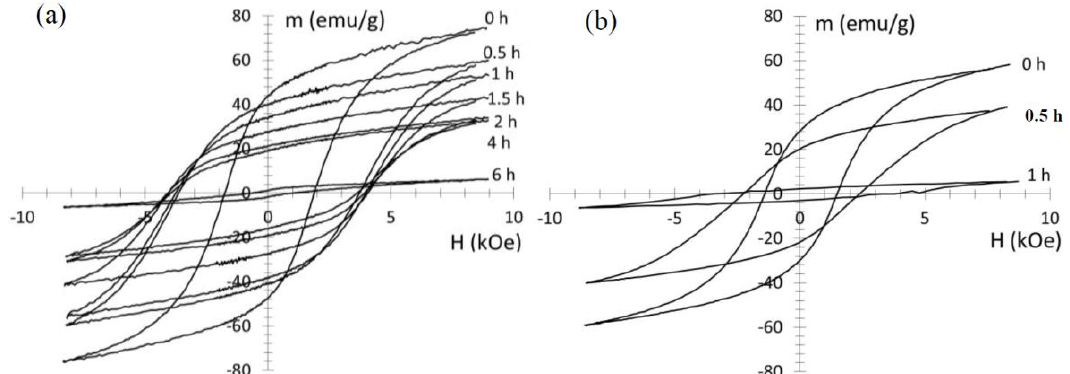
Figure 5. ( a ) Hysteresis loops for ε phase-milled samples for different milling times, after conversion of ε to τ; ( b ) Hysteresis loops for samples milled in the τ phase.